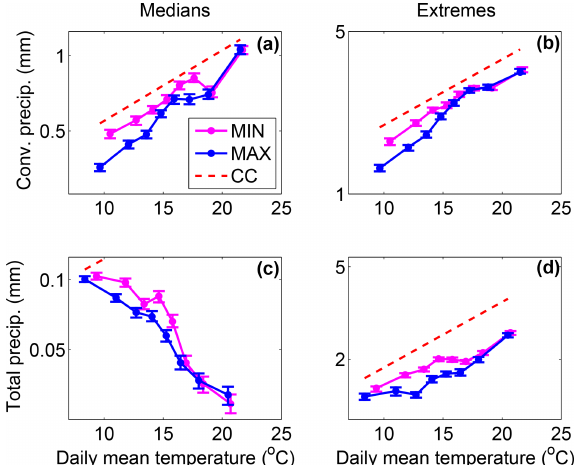
Figure 3. Hourly convective (a, b) and total (c, d) precipitation as a function of daily mean temperature at the surface for median (a, c) and extreme (95th percentile; b, d ) precipitation and for both the LR MIN (magenta) and LR MAX (blue) simulations. The dashed red line indicates the CC slope calculated using the August–Magnus– Roche approximation for saturated vapour pressure (Alduchov and Eskridge, 1996). Error bars represent the 95% confidence interval of the precipitation